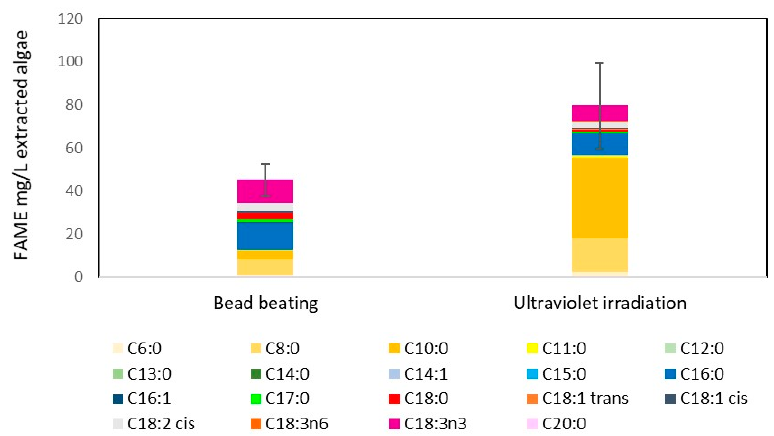
Figure 4. Comparison of biodiesel yield from disruption methods used on nitrate stressed C. reinhardtii . Fatty acid methyl ester yields from both bead beating and ultraviolet light irradiation disruption is shown. Yields represent transesterified lipids from 1 L of culture. UVB intensity at 1.5 W/cm 2 for 300 s (equivalent to 450 J/cm 2 UVB). Irradiation and bead beating carried out as in Materials and Methods. n = 2. Error bars represent the range. The legend indicates different FAME chain lengths.